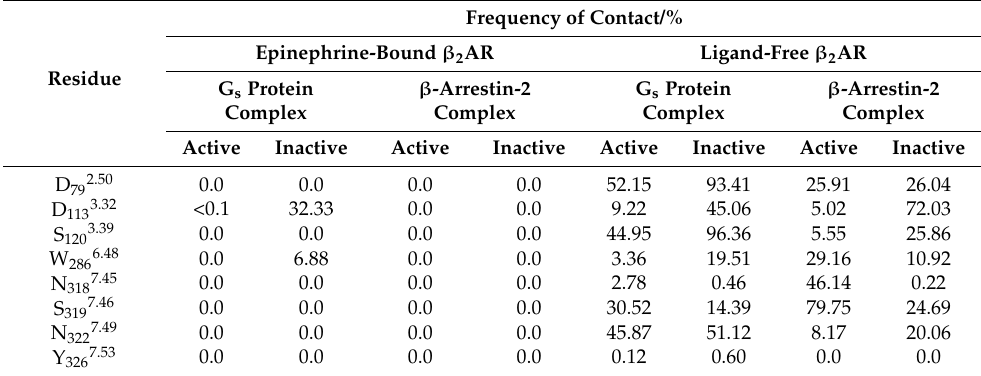
Table 1. The frequency of contact (d ≤ 0.4 nm) between Na + ions and polar amino acid side chains of the allosteric and orthosteric binding pockets and nearby conserved